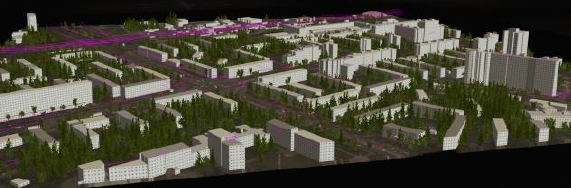
Figure 3. 3D visualisation in ENVI Lidar environment Global Mapper